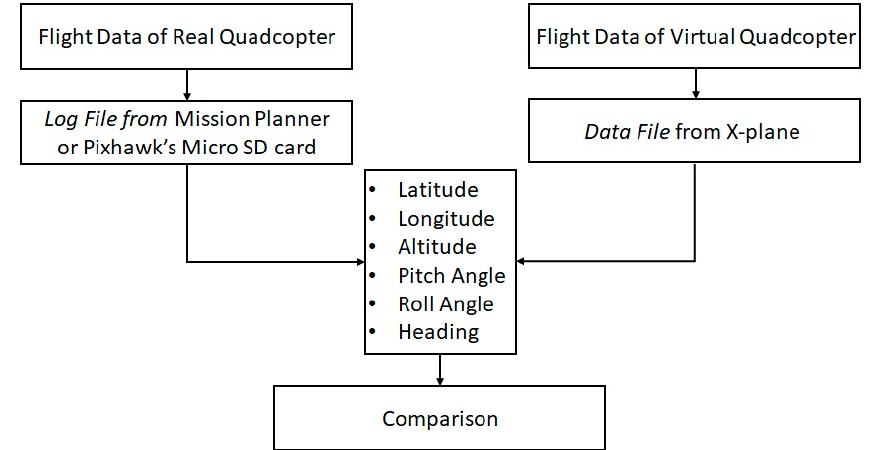
Figure 20. Data comparison procedure.